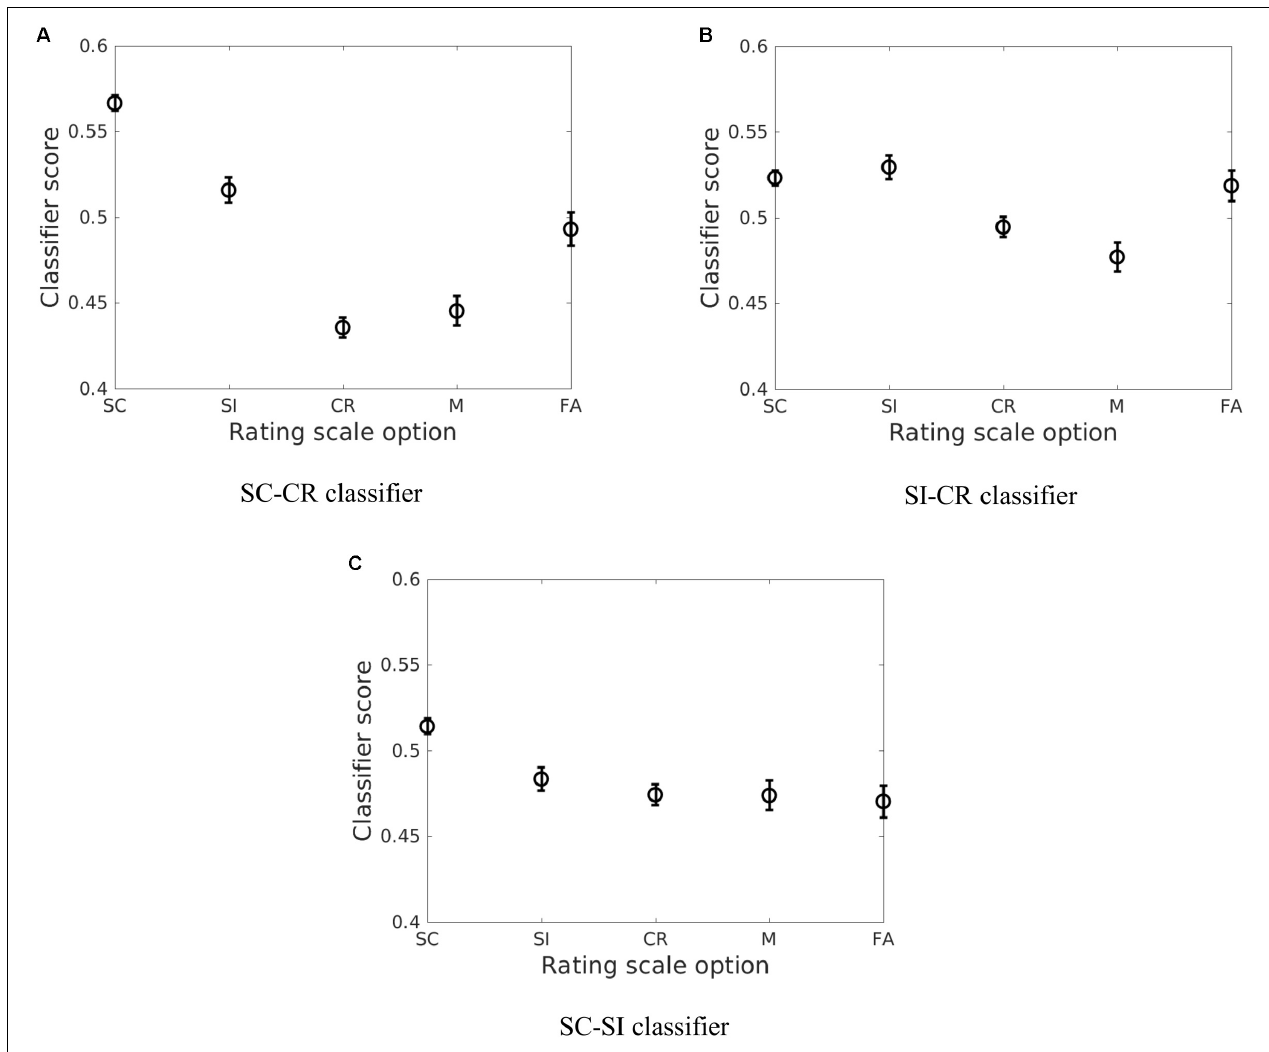
FIGURE 5 | The average of the estimated means and the approximate 95% confidence intervals of the classifier scores (Hochberg and Tamhane, 1987) across the four datasets [Exp 1 (loc), Exp 2 (col), Exp 3-loc, Exp 3-col] for the five behavioral conditions (SC, SI, CR, M, and FA) for the three different classification problems ( A : SC vs. CR; B : SI vs. CR; and C : SC vs. SI). TABLE 4 | The uncorrected pairwise comparison results for the five behavioral conditions across the four datasets [Exp 1 (loc), Exp 2 (col), Exp 3-loc, Exp 3-col]. SC vs. CR SC vs. SI SC vs. M SC vs. FA SI vs. CR CR vs. M CR vs. FA SI vs. M SI vs. FA M vs.